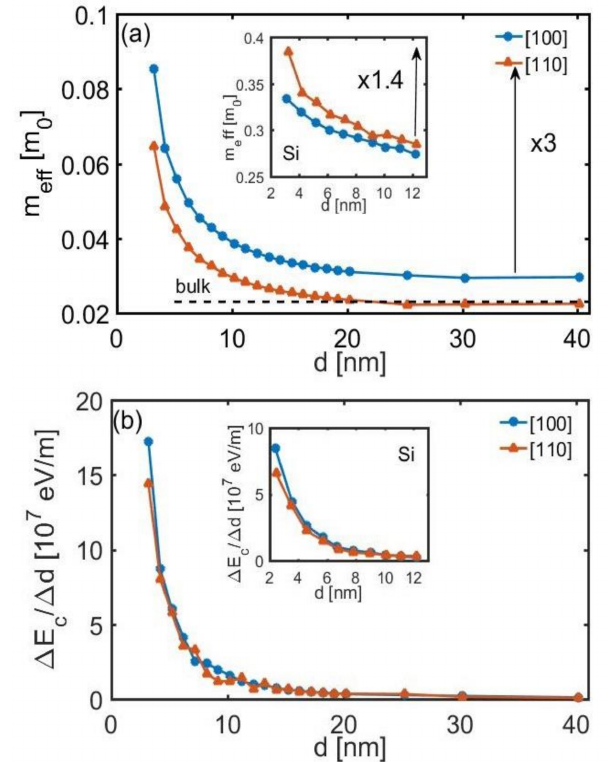
Figure 2. ( a ) The e ff ective mass of the first subband of InAs nanowires as a function of the nanowire diameter. An increase in the mass is observed as the diameter is reduced. ( b ) The differential of the